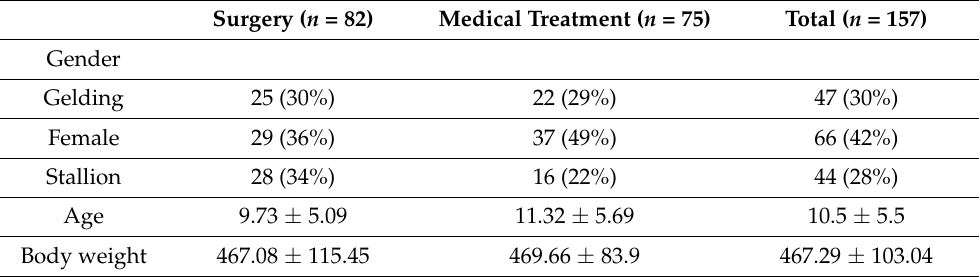
Table 1. Gender, age, and body weight of the selected horses. Gender is described by frequency distribution (%); age (years) and body weight (kg) are described by mean and standard